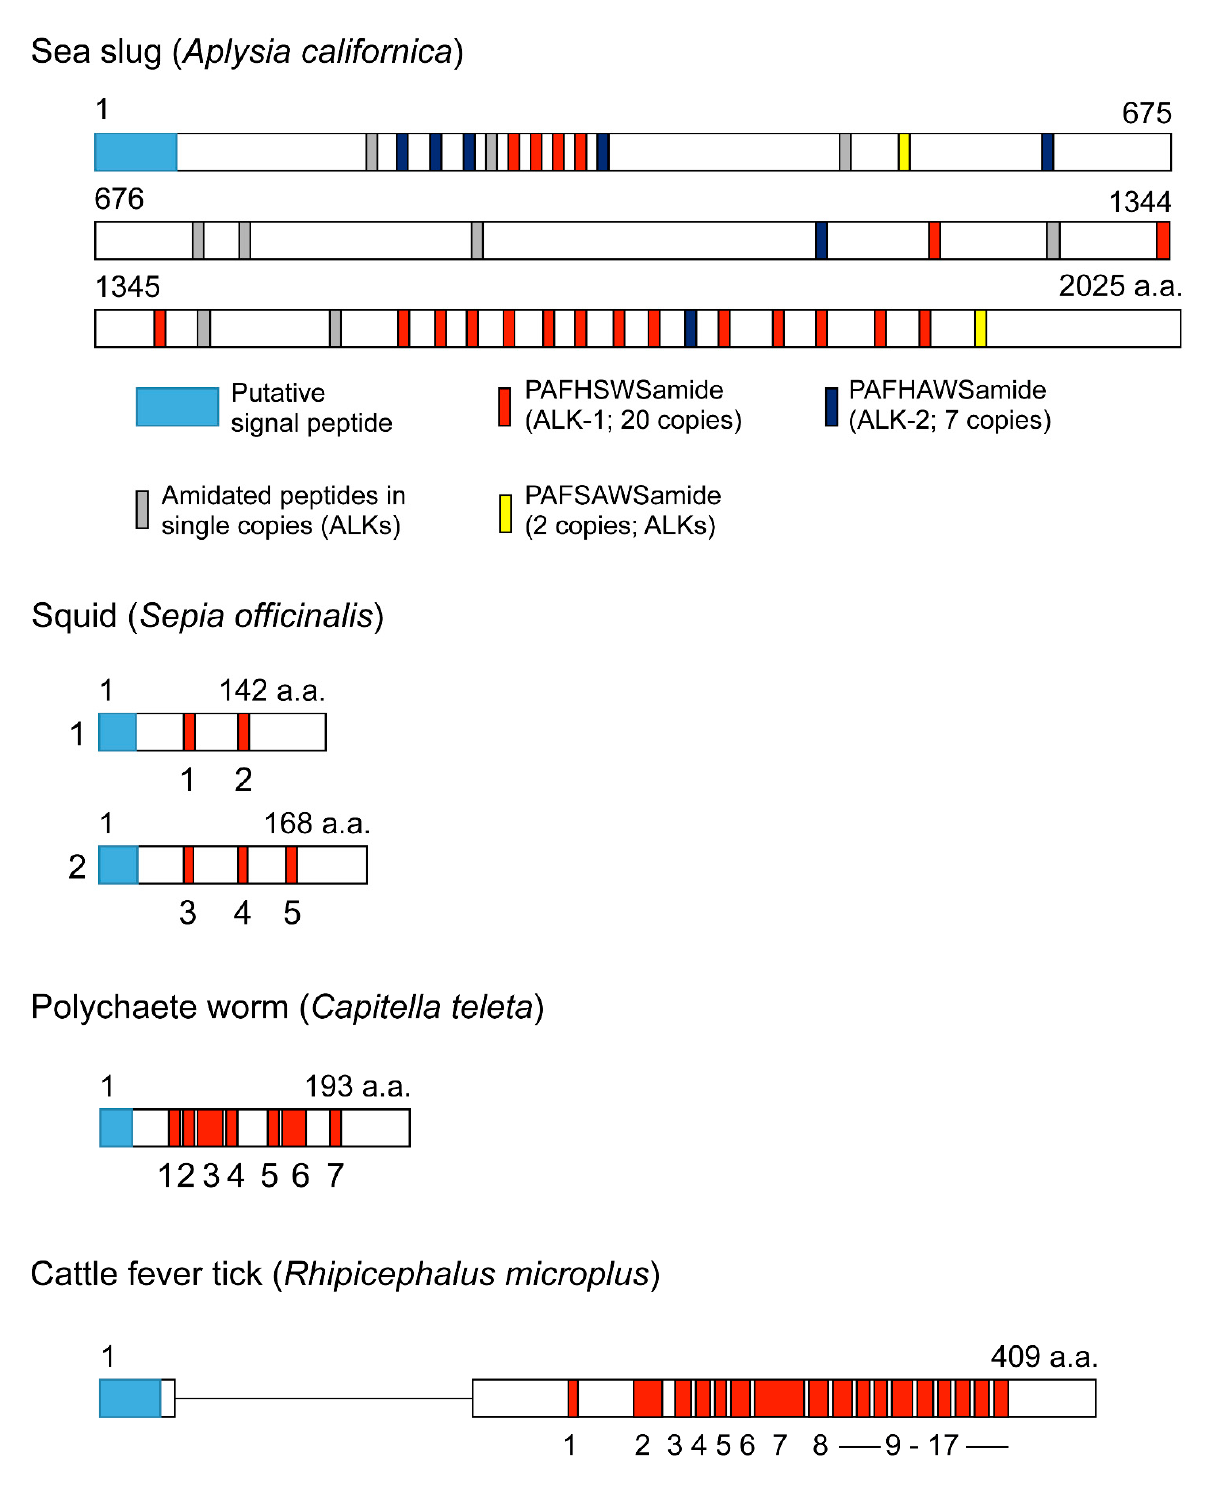
Figure 3. Schemes of representative bilaterian leucokinin precursors. Boxes and lines show exons and introns, respectively. Except for Aplysia , red boxes represent leucokinins, and signal peptides are indicated by blue boxes. Primary sequence data of Aplysia are from [22], squid from [58], polychaete worm from [15], and cattle fever tick from [59] .